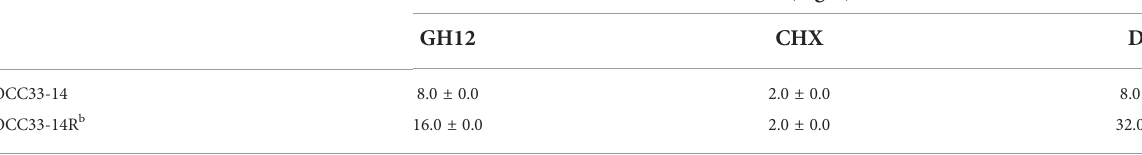
TABLE 2 Cross-resistance of GH12-resistant S. mutans COCC33-14 to CHX and DAP. Bacteria strains